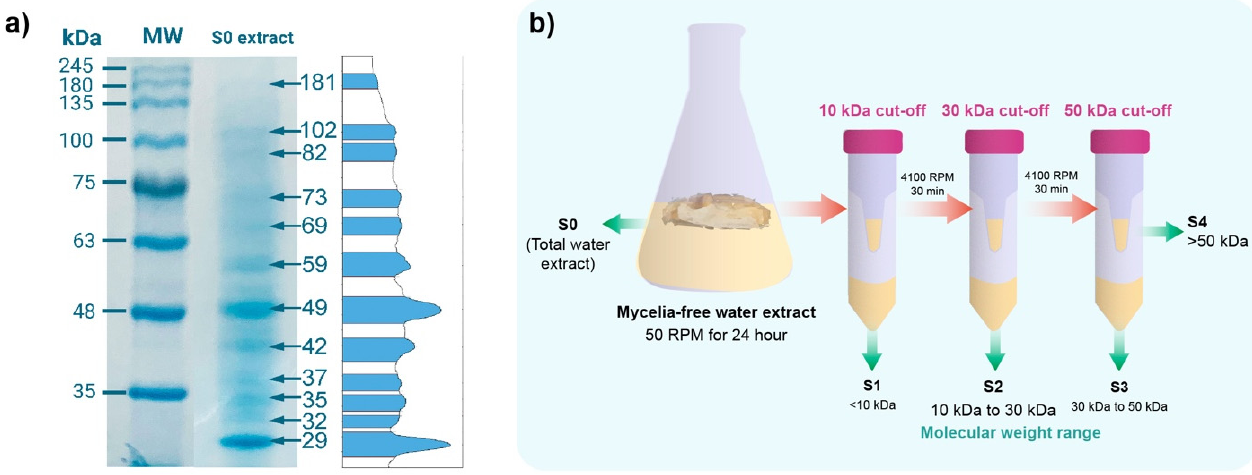
Figure 1. ( a ) SDS-page electrophoresis of the mycelia-free extract (S0) and ( b ) scheme of molecular weight fractionation of mycelia-free aqueous extract to synthesize AgNPs using Amicon ultra tubes. S0 to S4 indicate fractions used for the synthesis of AgNPs.